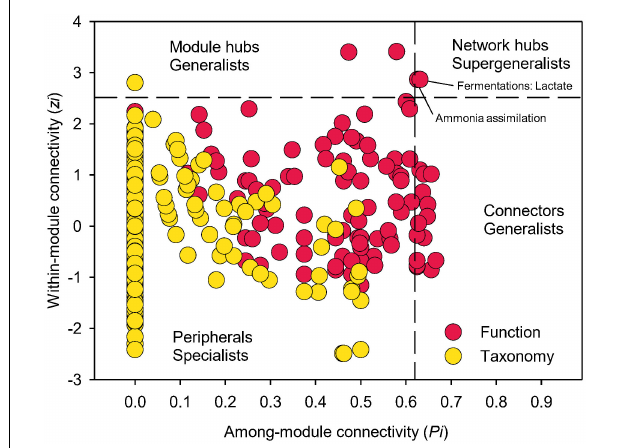
FIGURE 7 | Network information of functional and taxonomic compositions. Node distribution of module-based topological roles determined by the scatter plot of within-module connectivity ( zi ) and among-module connectivity ( Pi ) in soil metagenome networks annotated in the SEED Subsystems database at Level 3 (Function) and RefSeq database at genus level (Taxonomy). The threshold values of Zi and Pi for categorizing were 2.5 and 0.62,